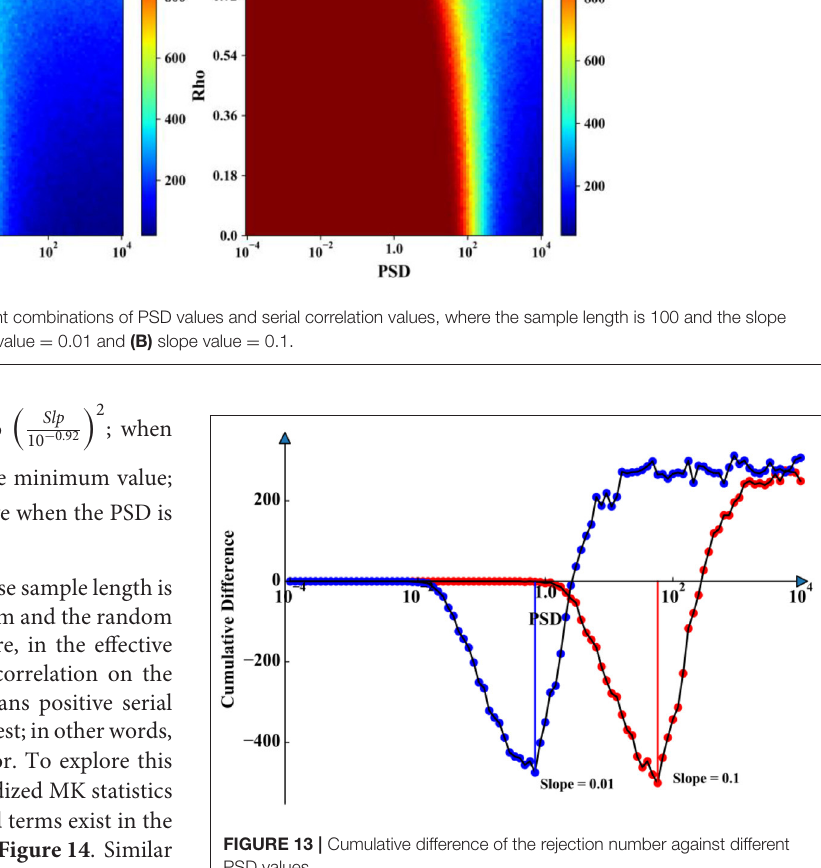
FIGURE 13 | Cumulative difference of the rejection number against different PSD